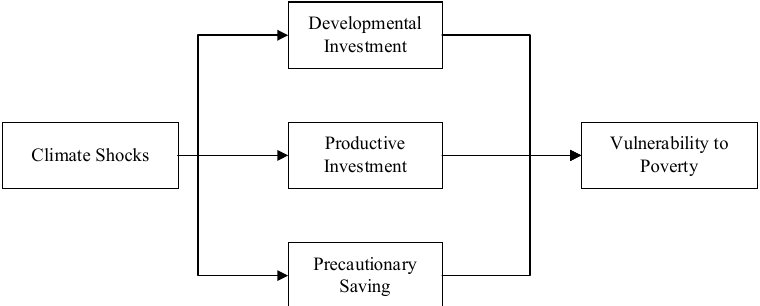
Figure 1. Climate shocks, household resource allocation, and vulnerability to poverty.